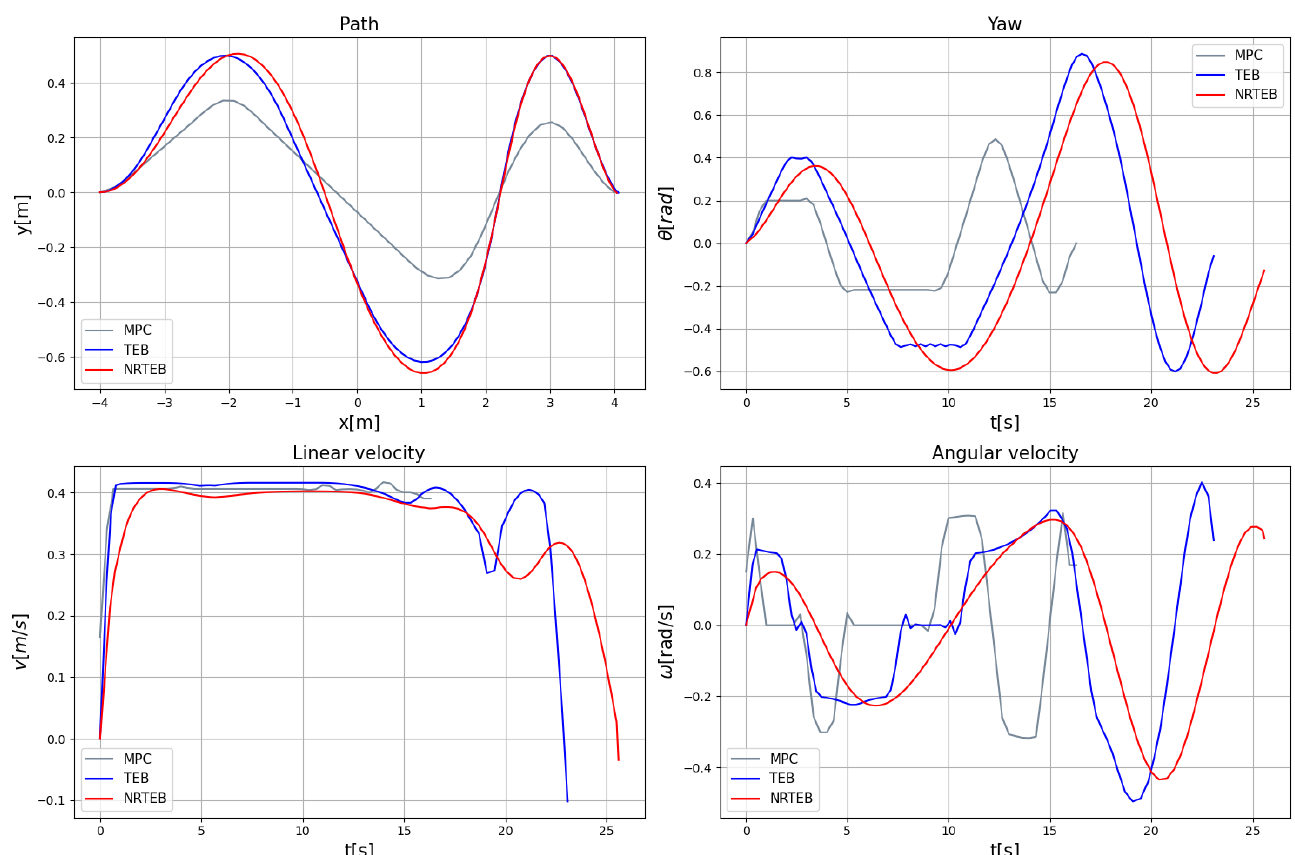
Figure 9. Comparison of MPC, TEB, and NRTEB in the path, heading angle, linear velocity, and angular